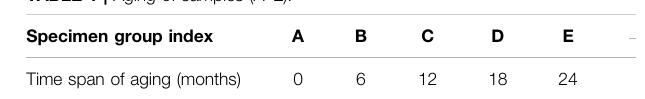
TABLE 1 | Aging of samples (A – E).